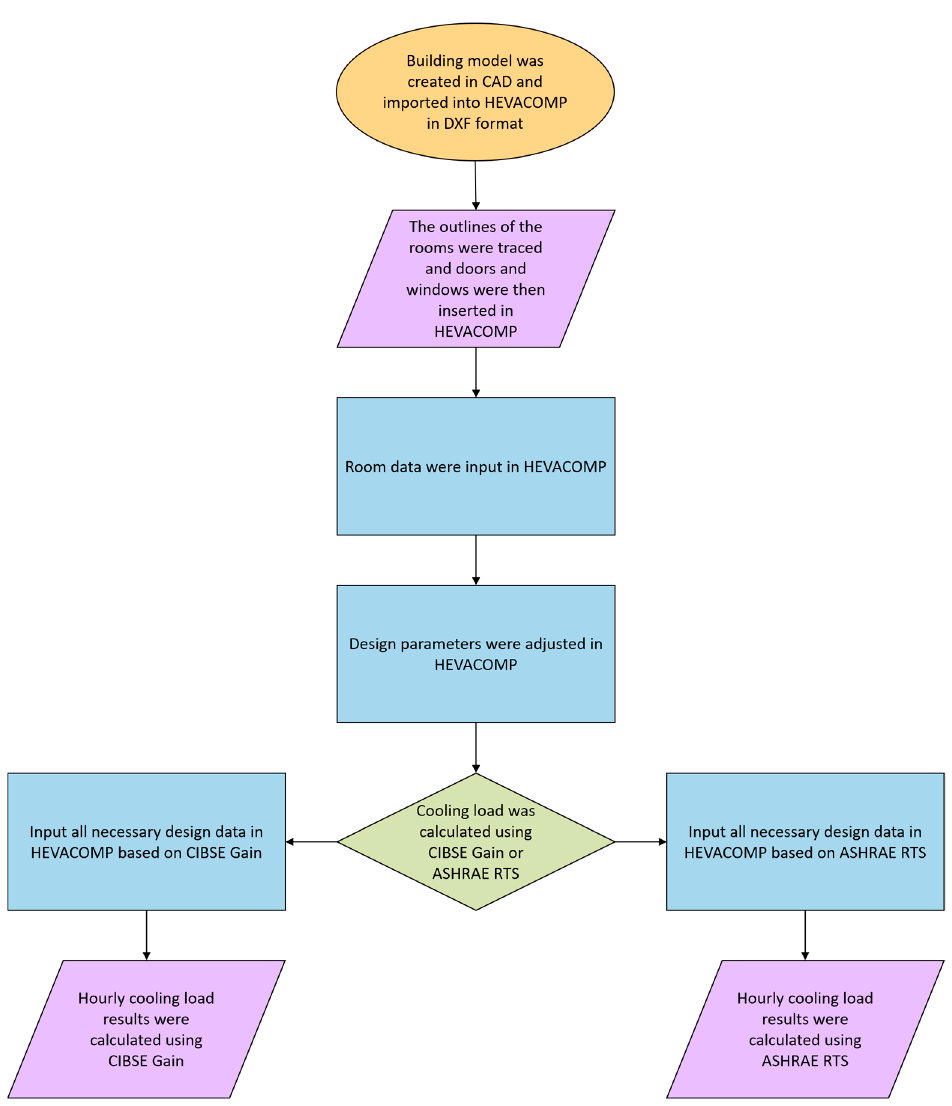
Figure 3. Thermal modelling procedure for the proposed methods.